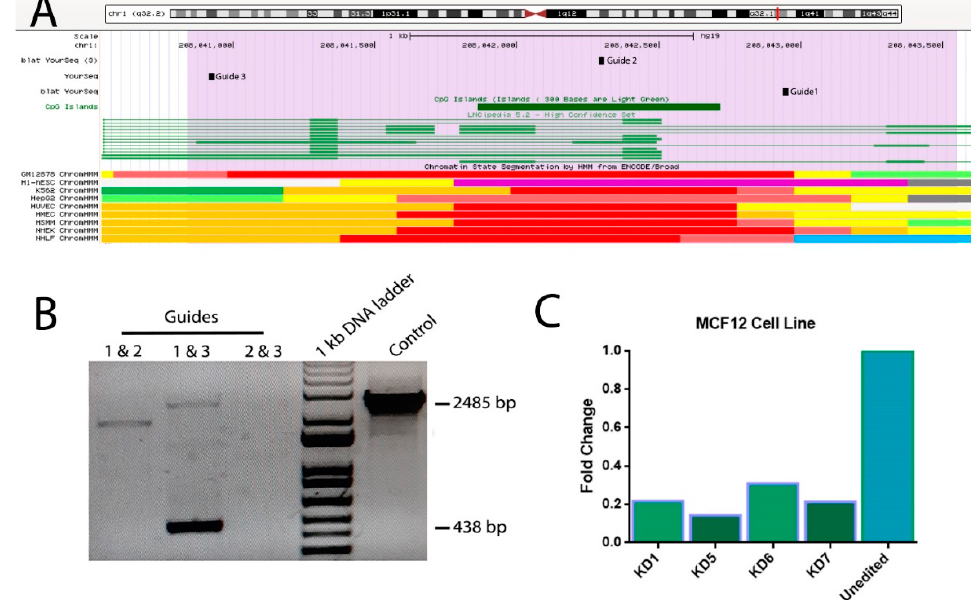
Figure 5. Removing C1orf132 p2 genomic region using three different guide RNAs. ( A ) The genomic locations targeted with guide RNAs are depicted as guides 1–3 on putative p2 region (highlighted by purple color), ( B ) following transfection of different pairs of guide RNAs into MCF12A cells, using gRNAs 1 and 3 led to the generation of a sharp PCR product of 438 bps caused by a genomic deletion of about 2000 bps. ( C ) Real-time PCR for C1orf132 long transcript expression on four different MCF12A edited cell colonies in comparison to the unedited cells is shown.